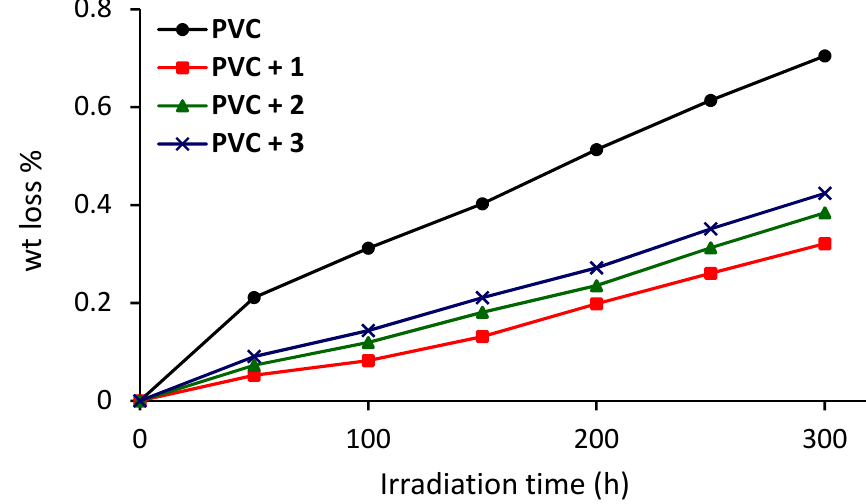
Figure 4. Changes in weight loss (%) of PVC films.